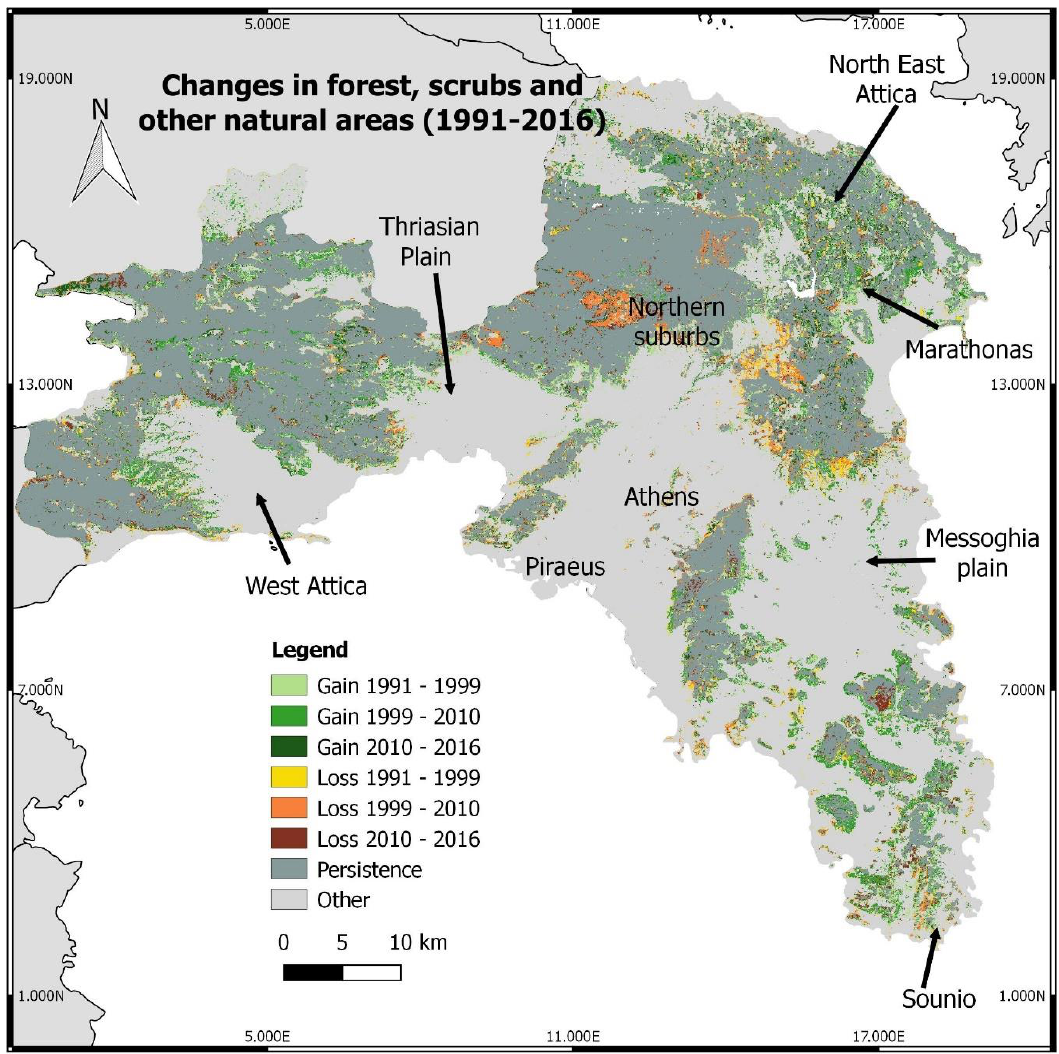
Figure 6. Changes in forests and natural areas observed between 1991 and 2016.